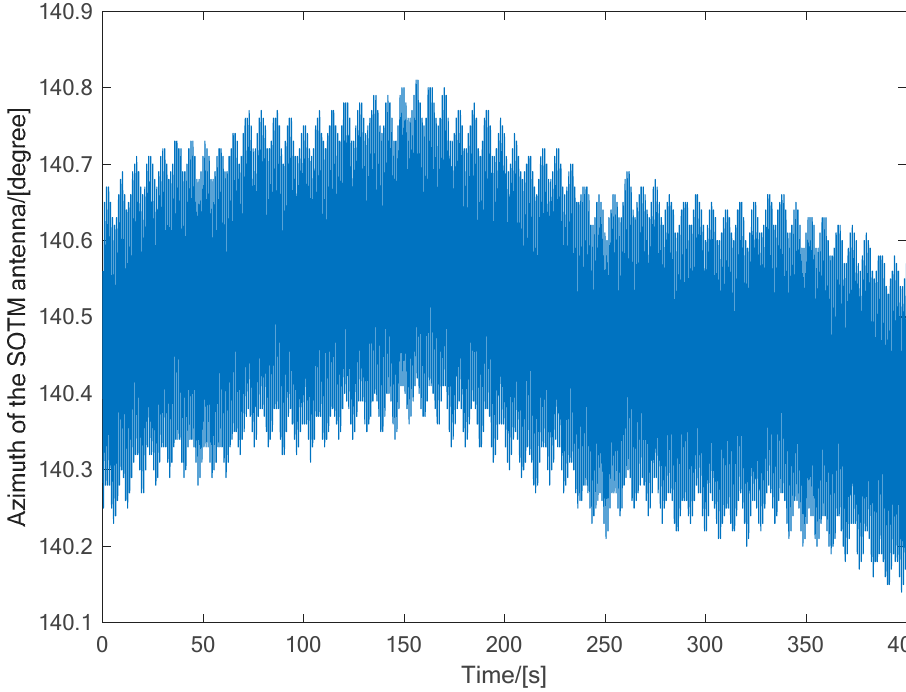
Figure 12. Azimuth angle of the SOTM antenna of the method in this paper.